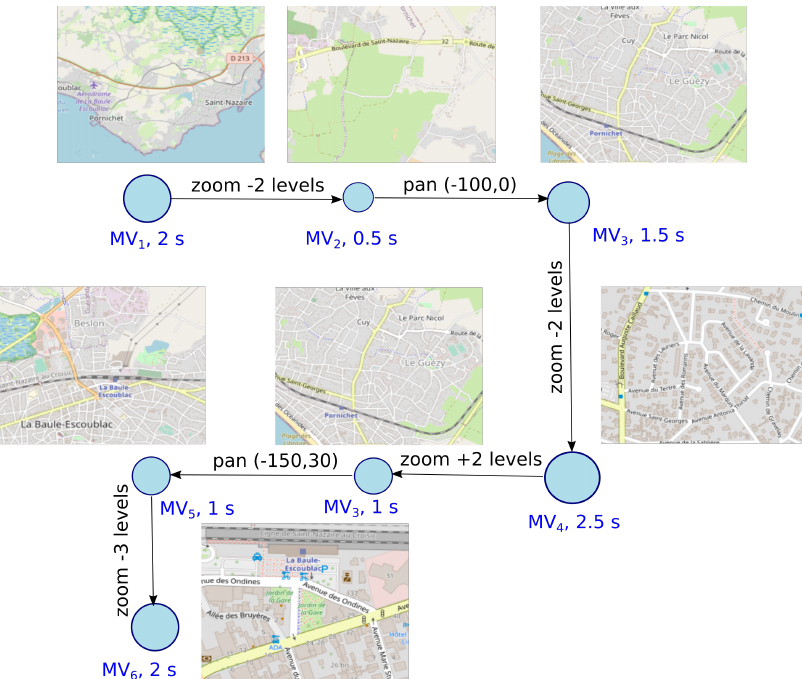
Figure 7. A pan-scalar map exploration to search for the train station of La Baule in France. The exploration was composed of phases where the user inspected map views and transition phases between two map views (source: OpenStreetMap contributors).